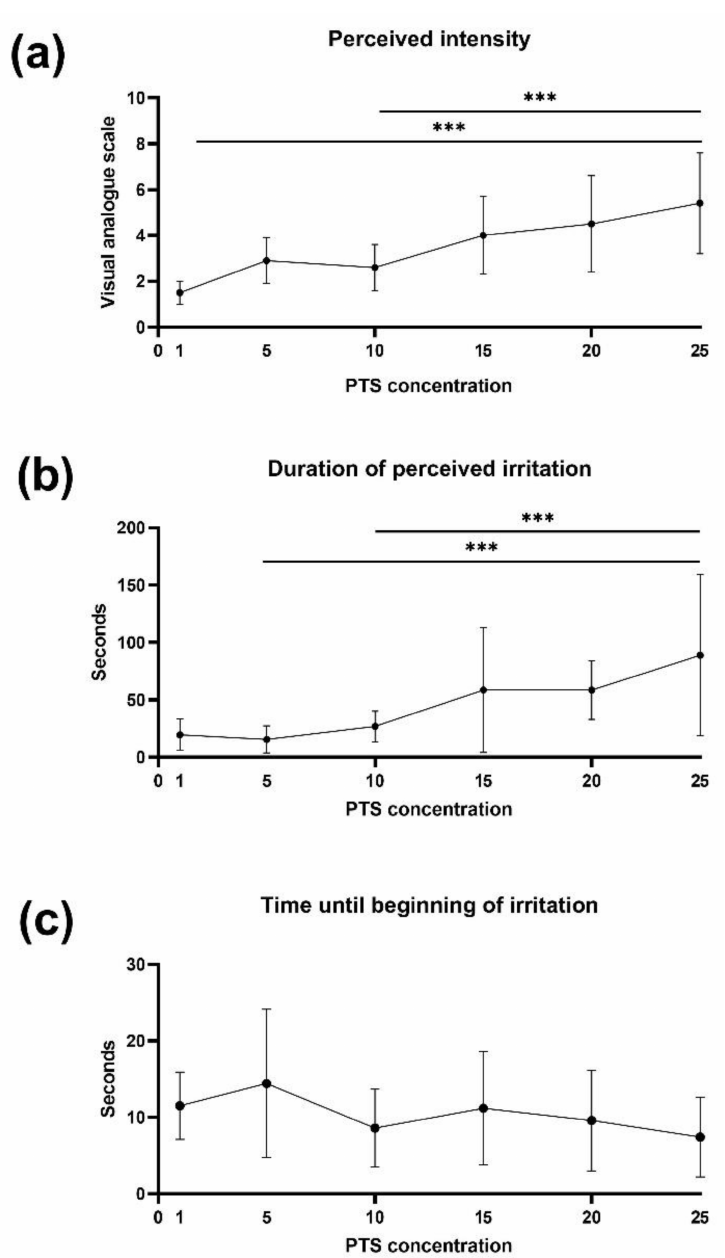
Figure 1. Psychophysiological responses to piperine impregnated taste strips (PTS) of Experiment 1 (n = 12). ( a ) The intensity of perceived irritation. ( b ) The duration (seconds) of perceived irritation. ( c ) The duration (seconds) until an irritation was perceived. The middle point represents the mean, and the error bars mark the standard deviation. Groups were compared using the rm-ANOVA test with post-hoc Tukey’s test. *** p <